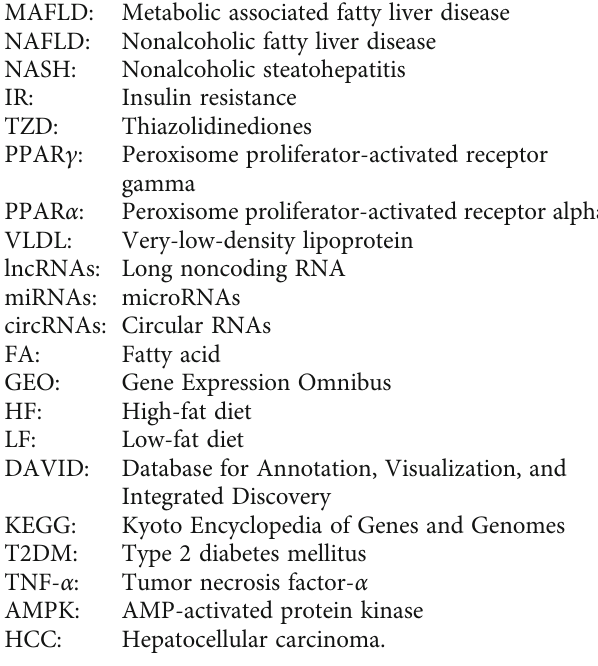
Supplementary Figure 1: KEGG pathway enrichment and protein-protein network of mouse NAFLD DEGs. A. Top 4 enriched pathways with signi fi cant FDR score. B. protein- protein network illustrating PPARs signaling genes as red, metabolic pathway genes as blue, insulin signaling pathway genes as green, and glycolysis/gluconeogenesis genes as yellow nodes. Supplementary Table 1: the summary of fatty liver disease-related miRNAs [34-58]. Supplementary Table 2: the summary of fatty liver disease-related lncRNAs [15, 58 – 87]. Supplementary Table 3: the summary of fatty liver disease- related circRNAs [88-99]. (Supplementary